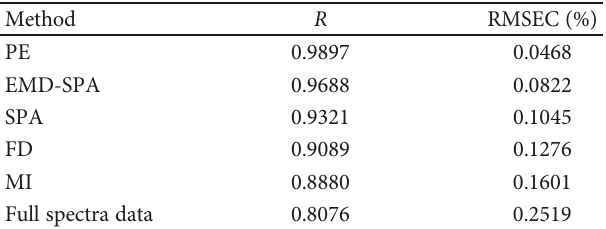
Table 3: R and RMSEP of PLSR model.